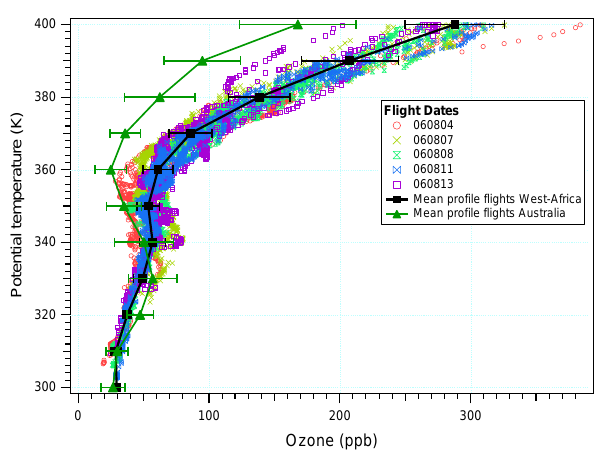
Fig. 3. Ozone profiles for the five local flights. The average profiles is indicated with the black line. The green line represents the av- erage ozone profile for the SCOUT-O3 campaign over Australia in November/December